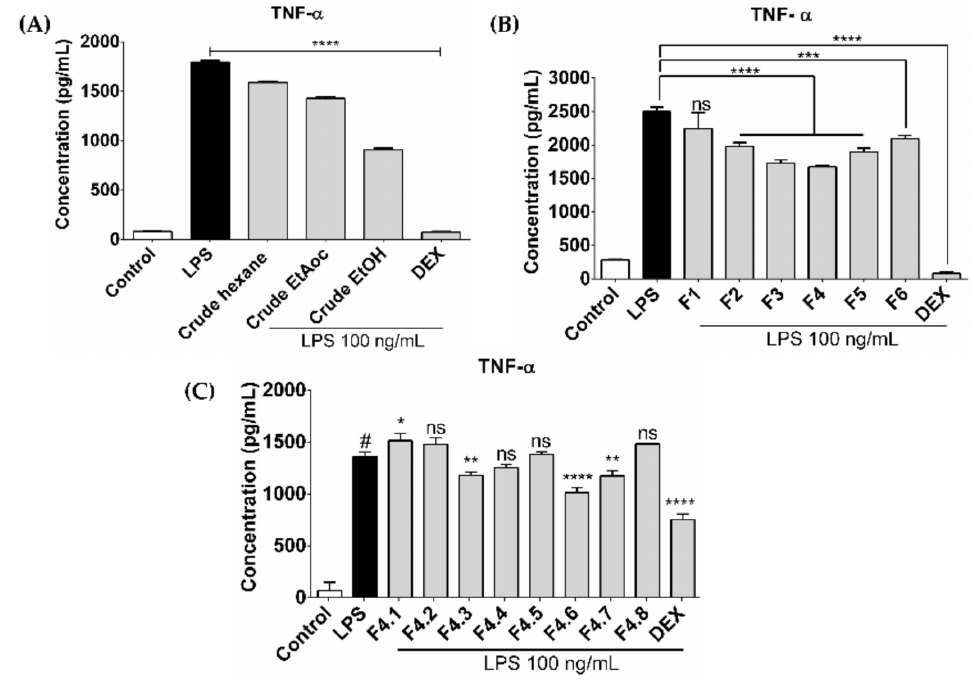
Figure 1. Anti-inflammatory effect of crude, fractions, and sub-fractions C. hystrix leaves on TNF- α production. Level of TNF- α release after treatment with crude extracts ( A ), fractions ( B ) and sub-fractions ( C ) in an LPS-induced human MDMs model. Data are presented as mean ± SD. * p < 0.05; ** p < 0.01; *** p < 0.001; **** p < 0.0001 compared to LPS treatment. LPS: Lipopolysaccharide-stimulated macrophages; Dex: Dexamethasone; F: